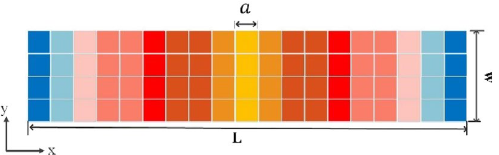
Figure. 5. Impedance distribution of the proposed reflectarray for the generation of flat-top pattern.